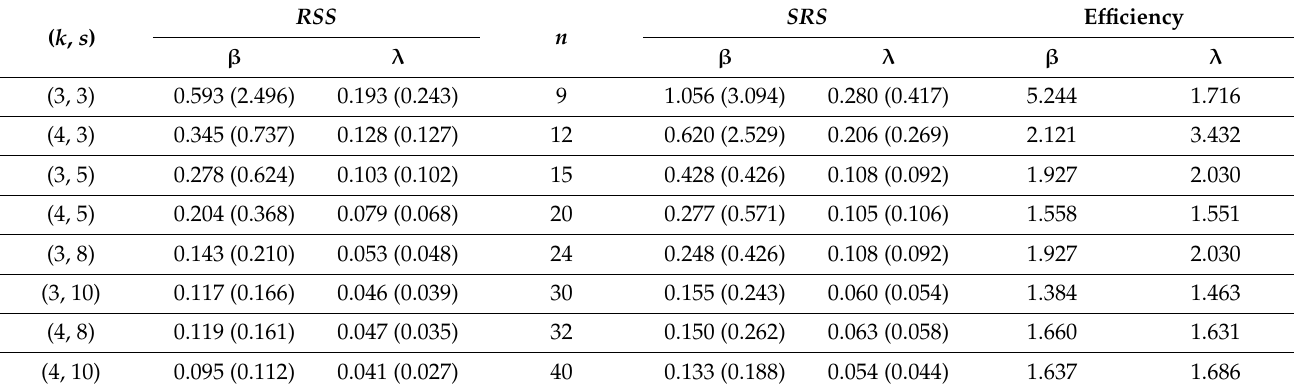
Table 3. The bias ( MSE ) and efficiency of the MLE parameters β and λ when β = 1.5 and λ =